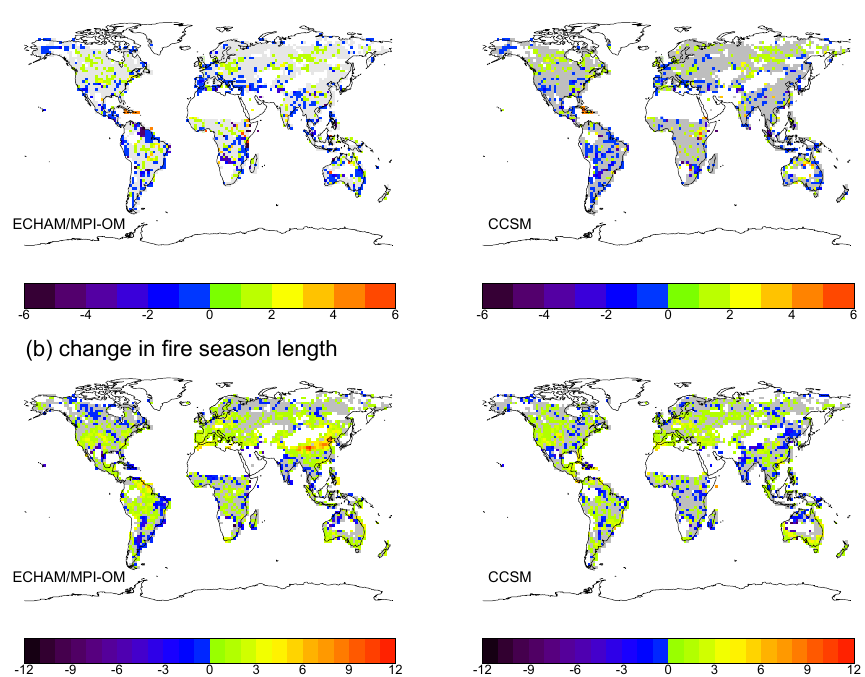
Fig. 7. Changes in fire seasonality averaged over the period 2075–2099 compared to the control simulation with constant climate. Left side: ECHAM/MPI-OM (AB-45-E1 minus AB-CLIM-45), right side: CCSM (AB-45-C1 minus AB-CLIM-45). 1st row: change in month with maximum burning [months]; 2nd row: change in number of months with fire occurence [months].